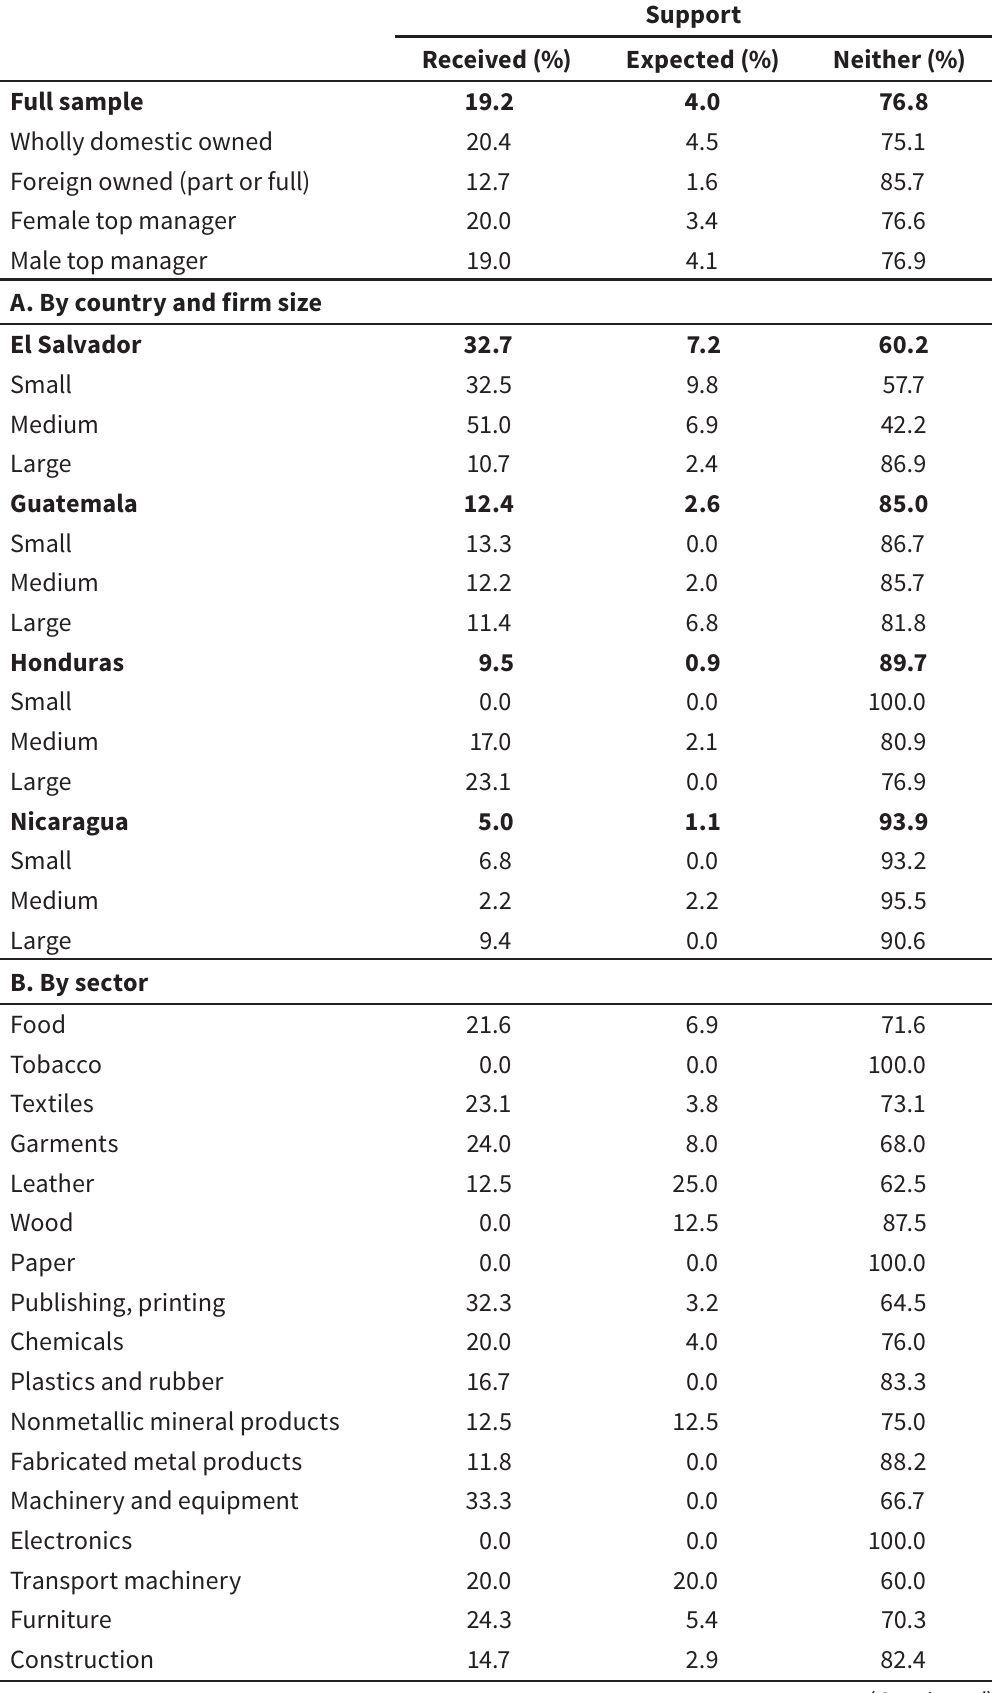
Recipients of government support (at time of the second COVID survey)